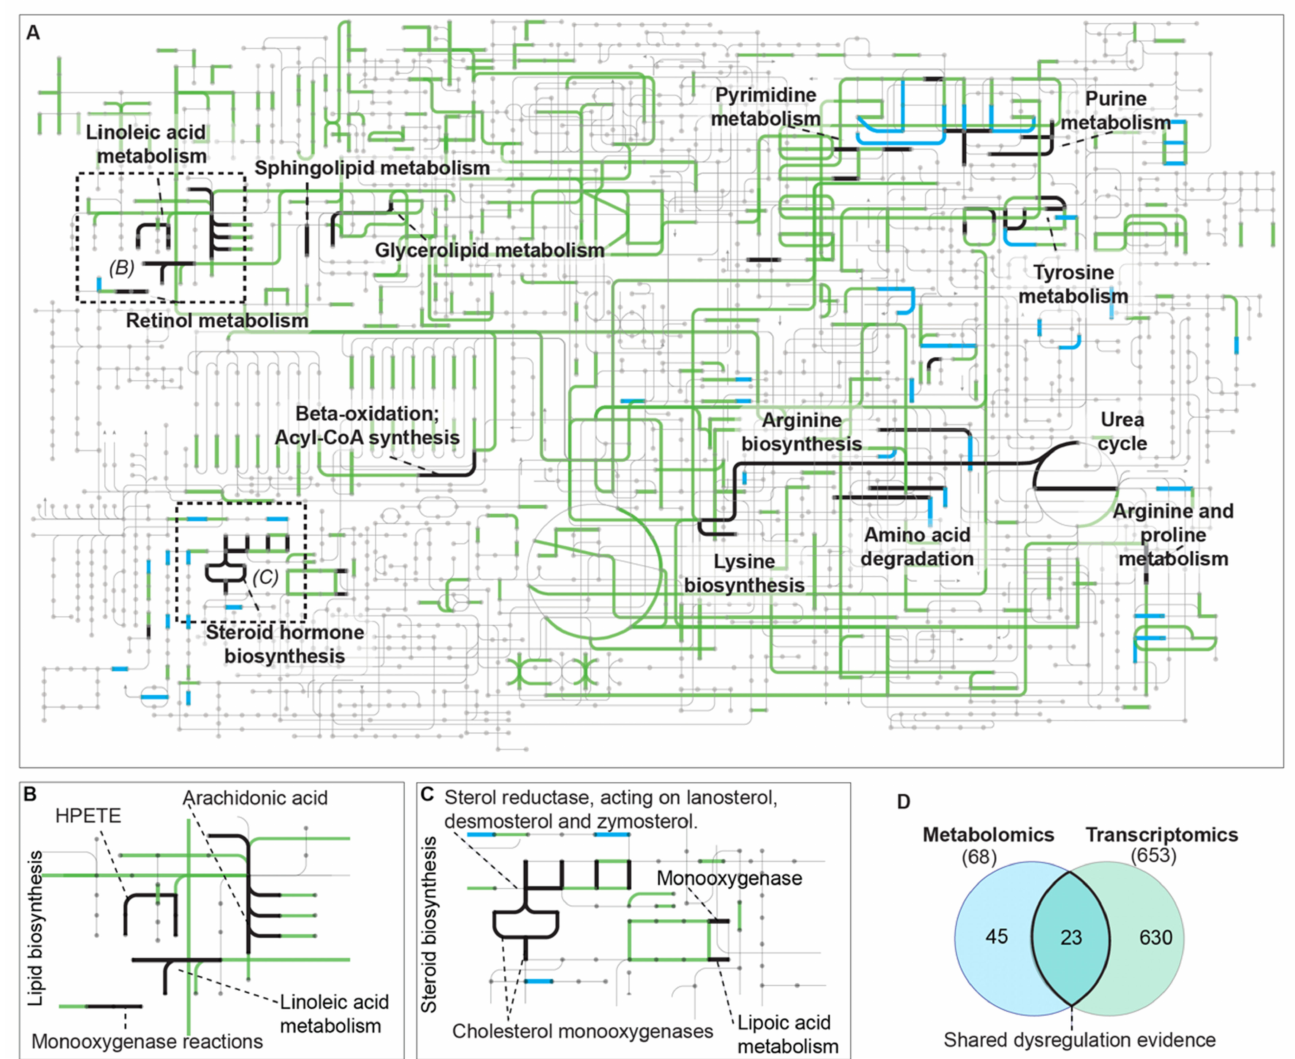
Figure 3. Overlap of metabolomic- and transcriptomic-predicted pathway dysregulation (as observed from cell pellets) in safranal-treated HCC cells. Maps show metabolites (gray dots), edges with no evidence (gray edges), transcriptomic reaction dysregulation evidence (green edges), metabolomic reaction dysregulation evidence (blue edges), and reaction dysregulation evidence from both omics experiments (bold black edges) after safranal treatment. Metabolites and their respective metabolic pathways were identified using LC/MS–QToF and Mummichog (http://mummichog.org/, accessed on 20 March 2021) in XCMS and their overlaps with those identified from RNAseq analysis (black edges, panels A–C). ( A ) Overview of metabolic dysregulation evidence from the dual omics exper- iments visualized in the Interactive Pathways Explorer v3 (https://pathways.embl.de/, accessed 29 May 2021). ( B ) Lipid biosynthesis dysregulation after safranal treatment (see also Table S2). ( C ) Steroid biosynthesis dysregulation after safranal treatment (see also Table S2). ( D ) Overlap of metabolomics and transcriptomics dysregulated metabolic reactions from CAS and EC